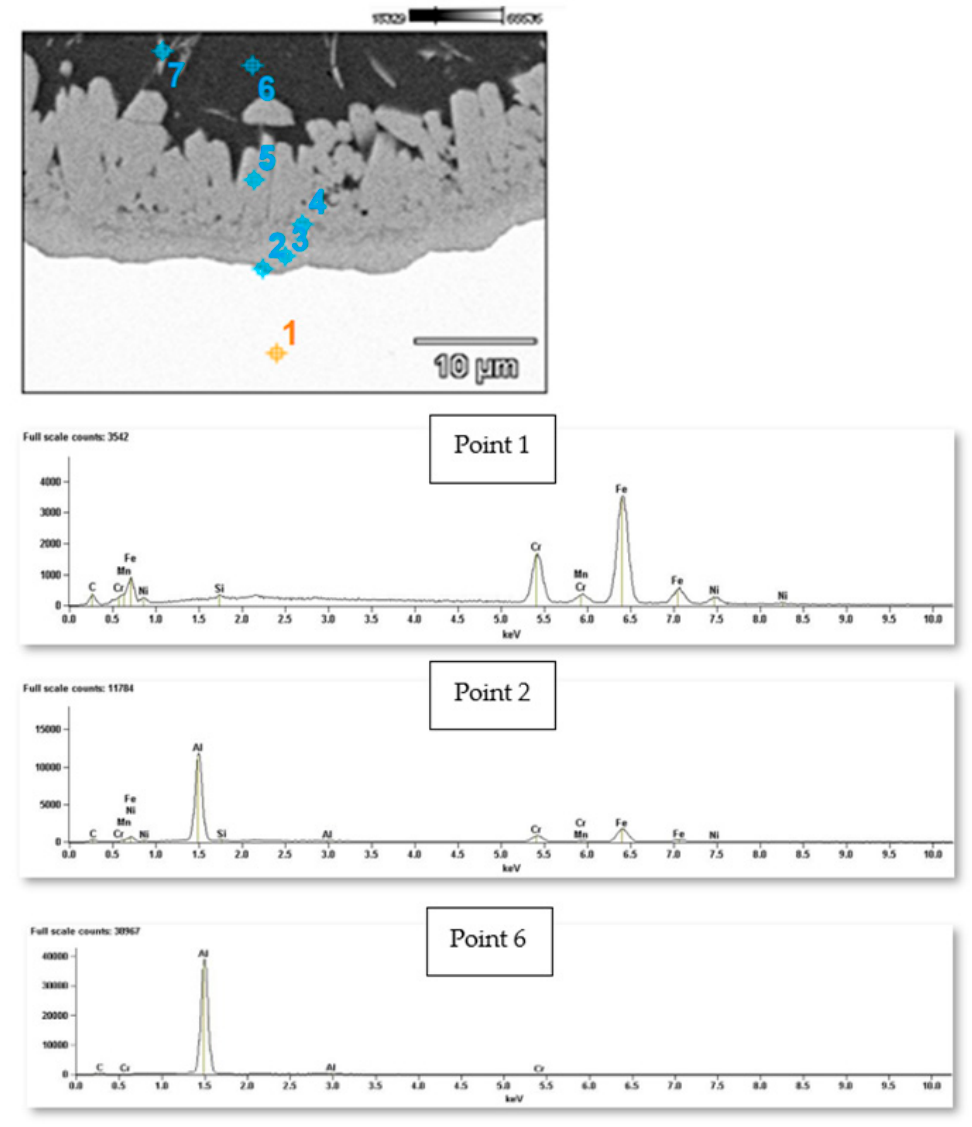
Figure 6. EDS composition estimates.